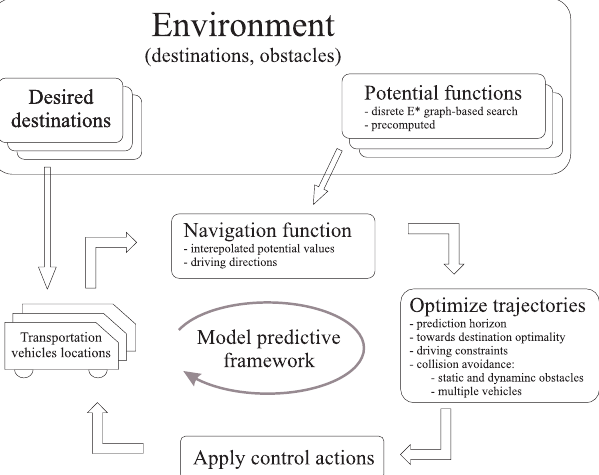
Figure 2. Basic idea of navigation and control of multiple vehicles based on the proposed navigation function and model predictive control.